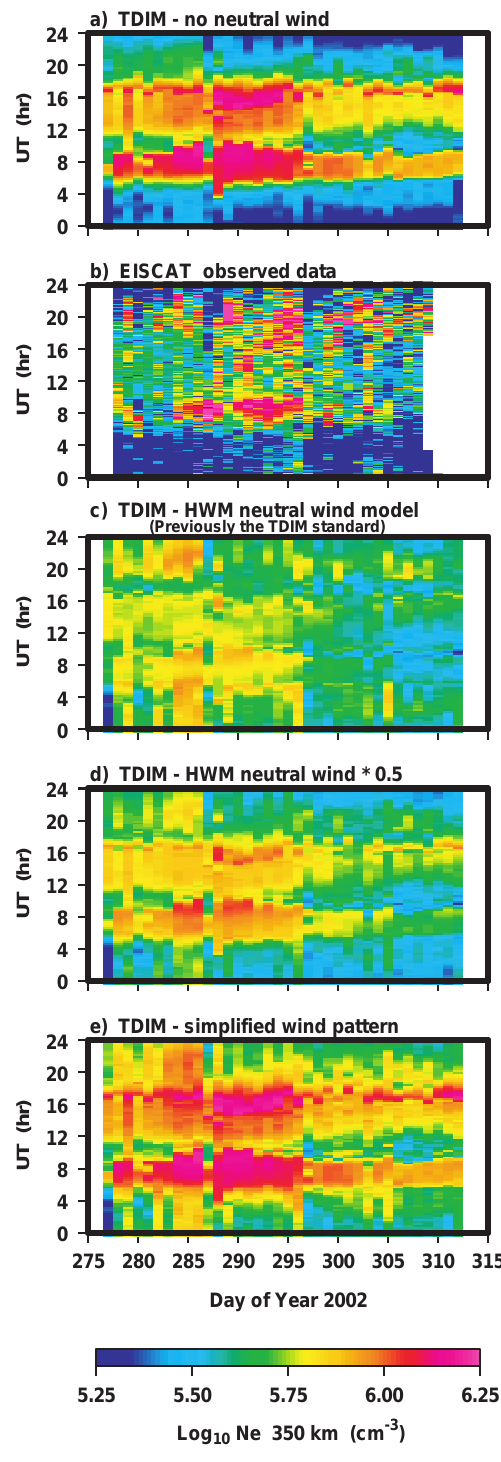
Figure 4 Fig. 4. Electron densities at Longyearbyen, at 350km altitude, dur-